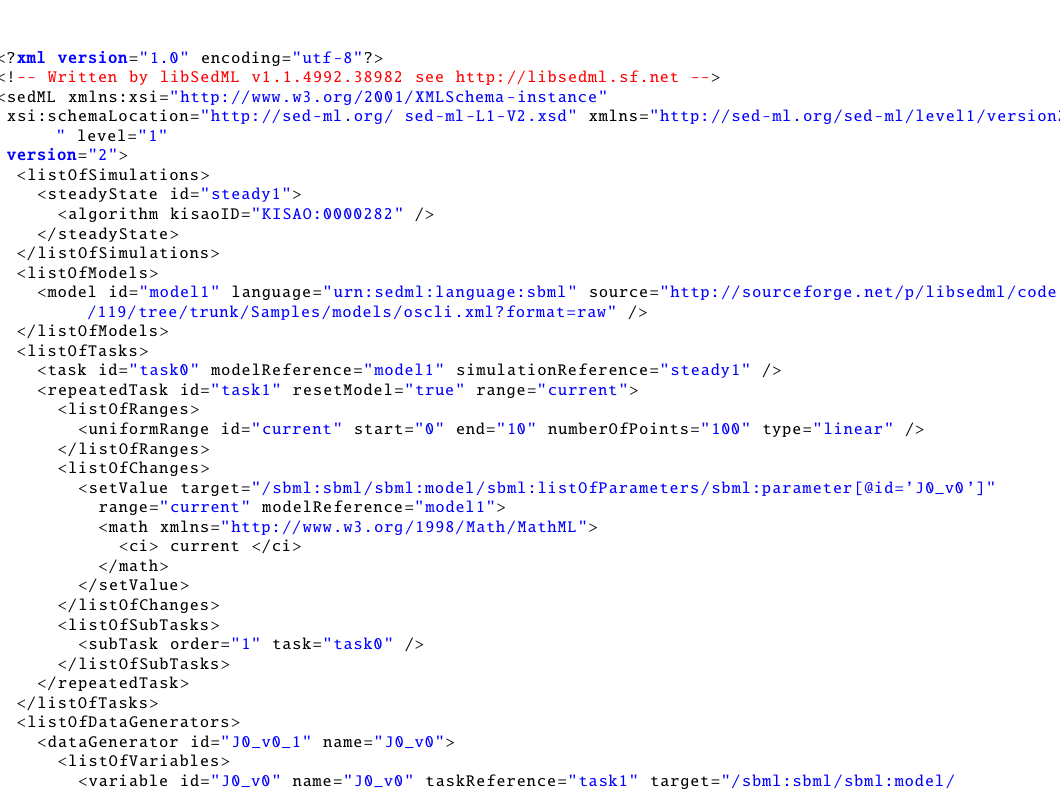
Figure C.4: The simulation result gained from the simulation description given in Listing